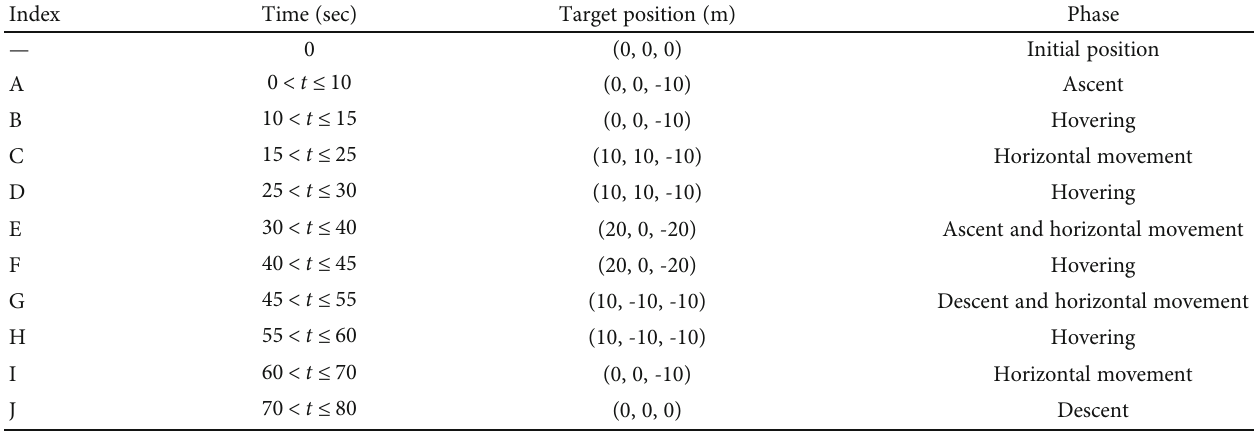
Table 1: Desired trajectory.